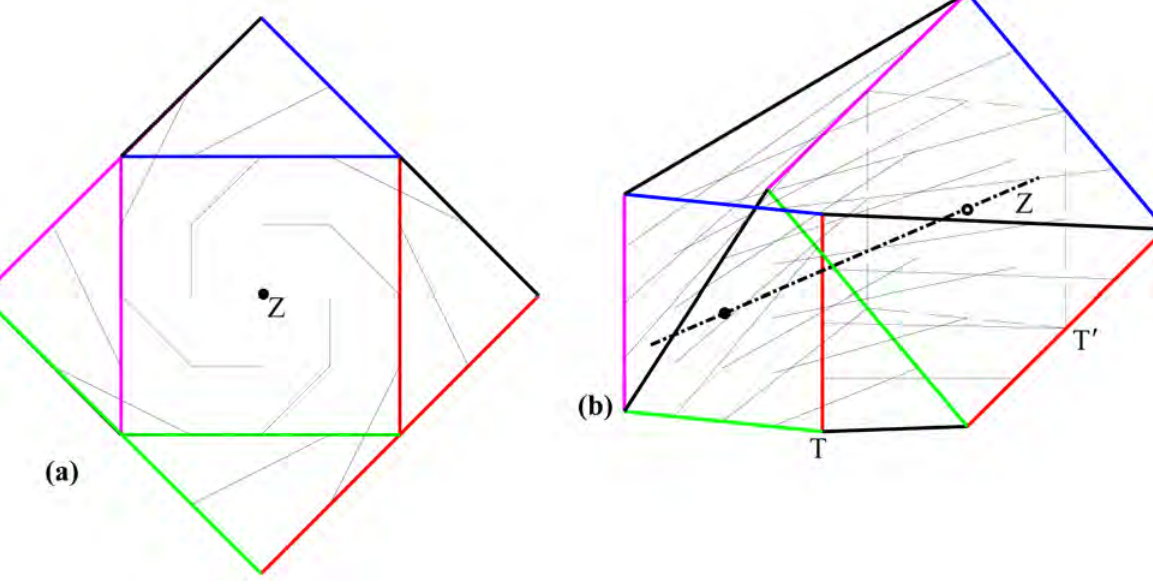
Figure 3 A pencil of divergency 2/ LM = D at entrance plane T. There are no principal meridional planes and no foci. (b) azi- muth °− 64 64 °− 64 , elevation 12 °− 64